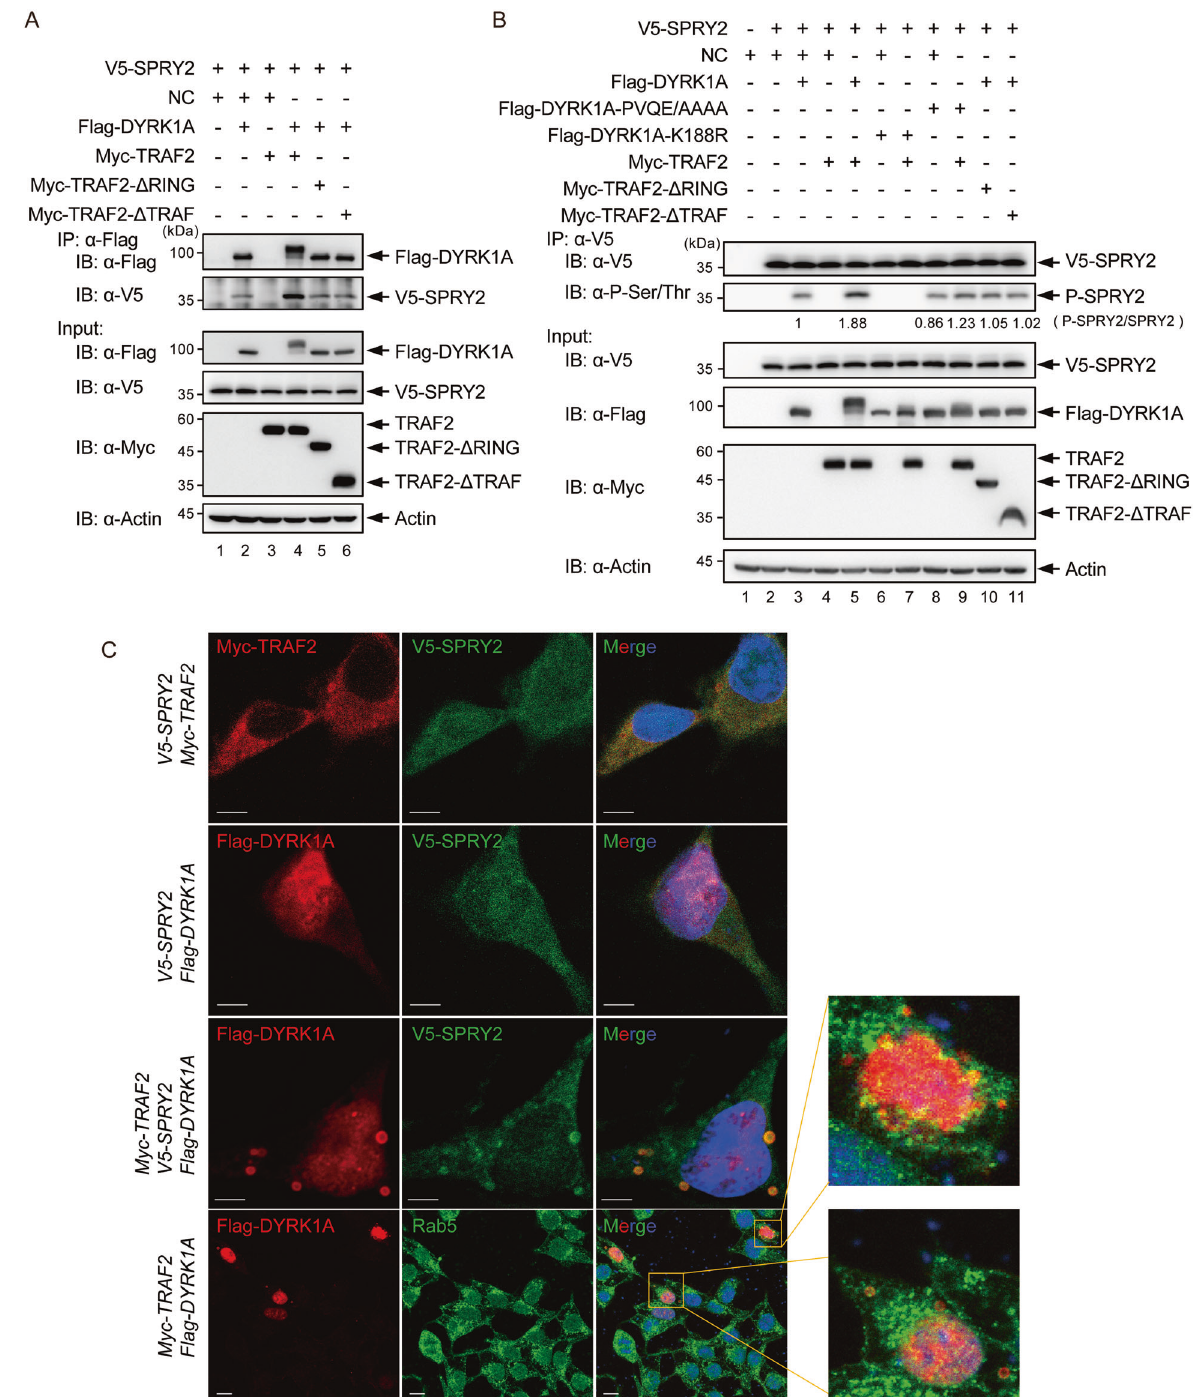
Fig. 5 TRAF2 promotes DYRK1A-mediated phosphorylation of SPRY2. A Interaction analysis between DYRK1A and SPRY2 in the presence of WT TRAF2 or its truncates. V5-SPRY2 was co-transfected with Flag-DYRK1A, Myc-TRAF2, or its different truncations into HEK293T cells and Flag-af fi nity puri fi ed. Immunoprecipitates were probed with α -Flag and α -V5 to analyze the enrichment of SPRY2 in DYRK1A pulldowns after overexpression of TRAF2 and truncates. B Analysis of phosphorylation status of SPRY2 in the presence of DYRK1A and TRAF2. V5-SPRY2 was co-transfected with Flag-DYRK1A (WT, PVQE/AAAA or K188R) and/or Myc-TRAF2 (WT, Δ RING or Δ TRAF) in HEK293T cells, followed by V5- af fi nity puri fi cation. Immunoprecipitates were probed with α -phospho-pan-Ser/Thr antibody. Full-length TRAF2, but not Δ RING or Δ TRAF deletions, was able to promote phosphorylation of SPRY2 in the presence of wild-type DYRK1A. Also, Flag-DYRK1A-PVQE/AAAA mutant did not promote the phosphorylation of SPRY2. C Cellular localization of V5-SPRY2, Myc-TRAF2, Flag-DYRK1A, and Rab5. HEK293T cells were co- transfected with V5-SPRY2, Flag-DYRK1A, and/or Myc-TRAF2, and immunostained with respective antibodies. Images were acquired using ZEISS 710 confocal laser scanning microscope. The fi rst three panels, scale bar = 25 μ m. The last panel, scale bar = 1 μ m.